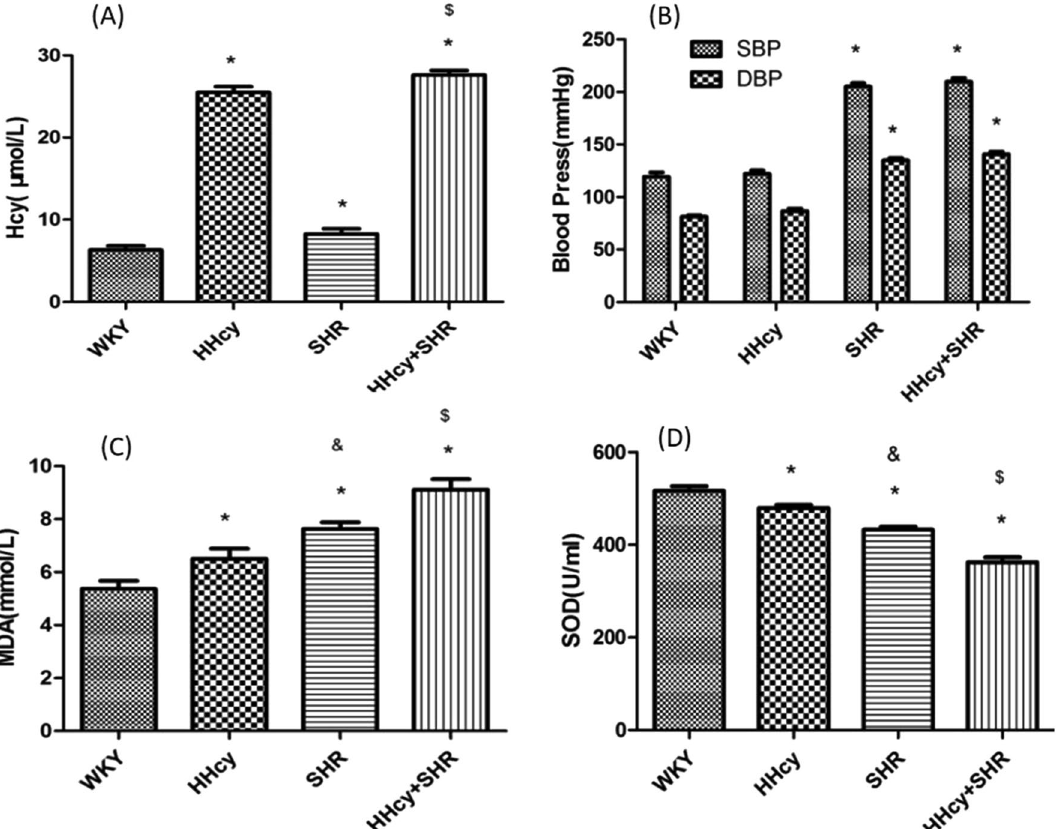
Figure 2. Plasma homocysteine (Hcy) level, serum malondialdehyde (MDA) level, serum superoxide dismutase (SOD) activity, and rat tail artery blood pressure in Wistar-Kyoto (WKY) group, hyperhomocysteinemia (HHcy) group, spontaneously hypertensive rat (SHR) group and HHcy + SHR group. ( A ) Plasma Hcy levels. ( B ) Blood pressure levels. ( C ) Serum MDA levels. ( D ) Serum SOD activity. Values represent means ± SD ( * P < 0.05 vs. WKY group, $ P < 0.05 vs. SHR group, δ P < 0.05 vs. HHcy group, n =